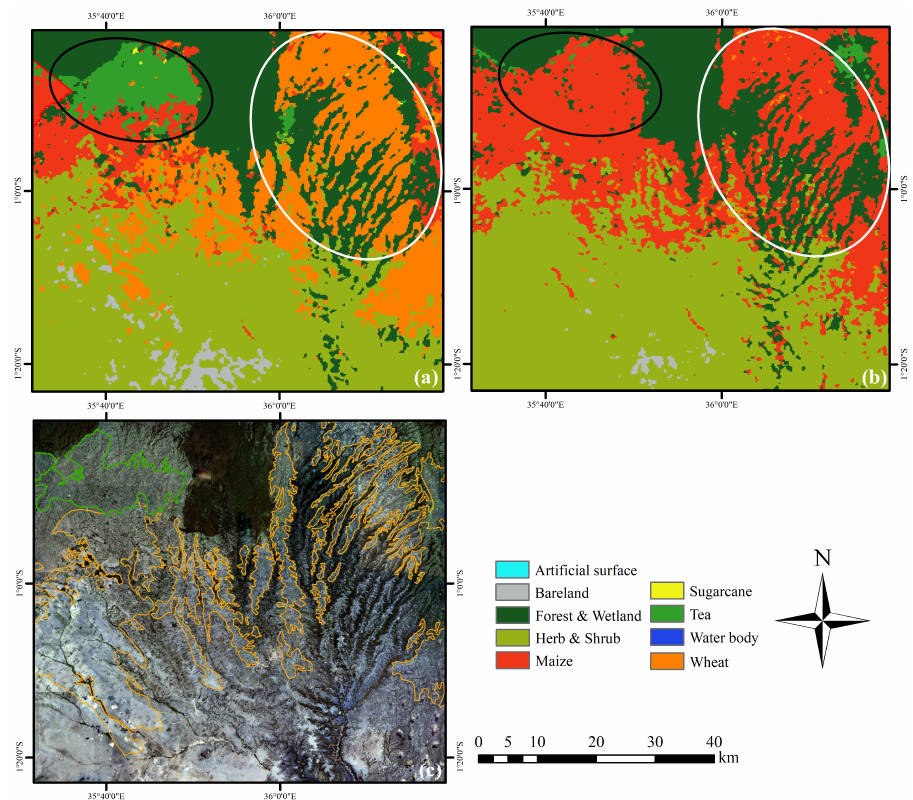
Figure 6. Comparison of the two classification strategies in extracting tea and wheat in northeastern Narok County. ( a ) The results of independent classification of each AZE; ( b ) the results of RF classification at a national scale; ( c ) Google Earth high-resolution image of the area. Note that the distribution of tea and wheat was provided by Crop mask 2015.